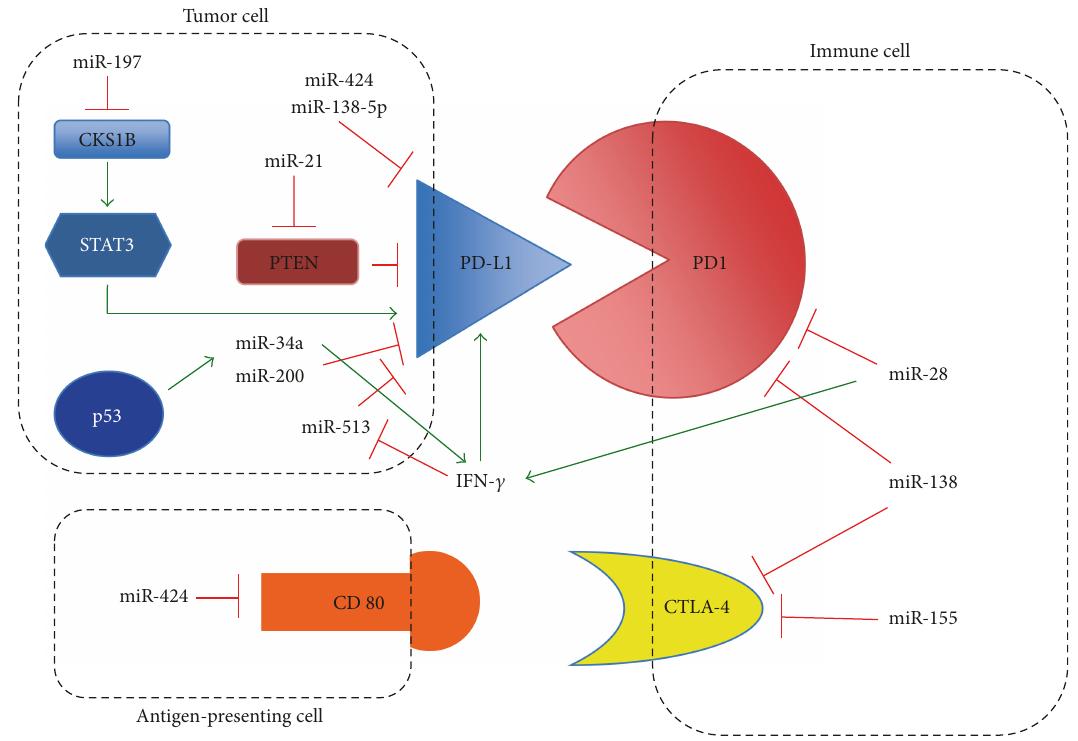
Figure 1: Interactions between miRNA and immune checkpoints. This nonexaustive scheme shows the major interactions between miRNA and immune checkpoint molecules. Red and green arrows indicate the suppressive or activating interactions,